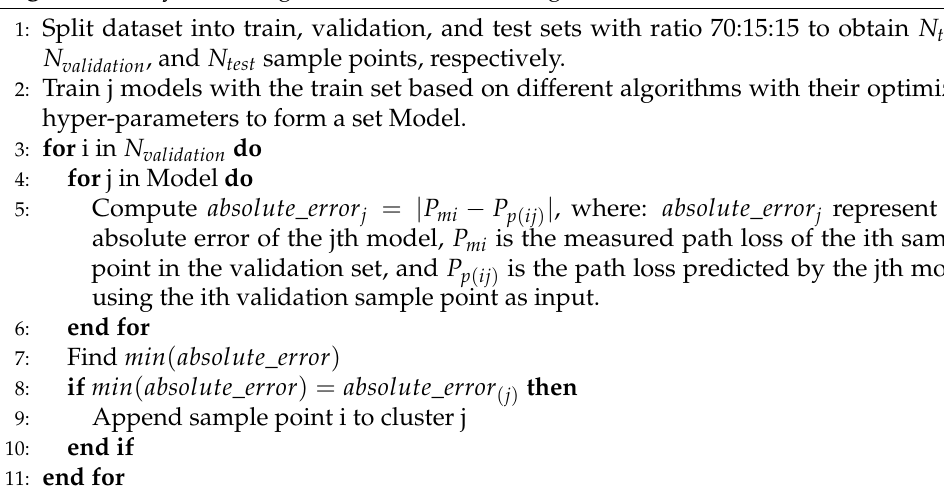
Algorithm 1 Dynamic Regressor Selection Training